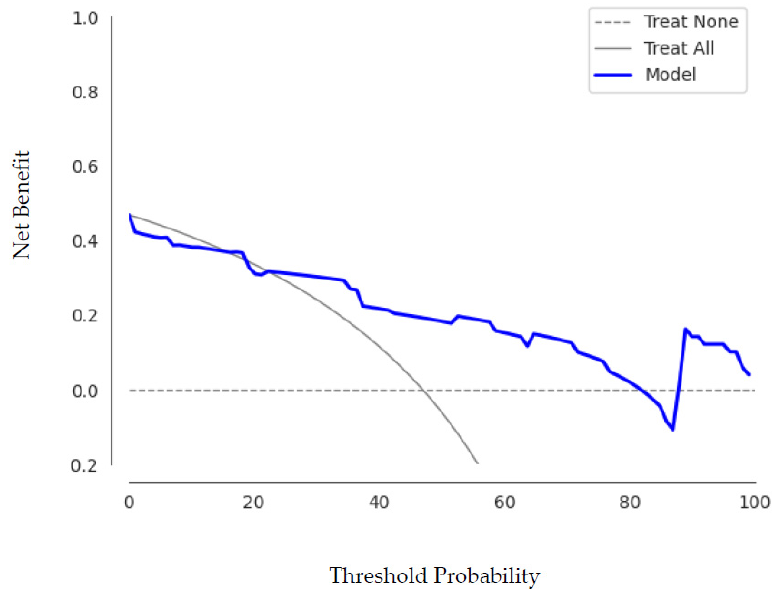
Figure 6. The decision curve analysis for the best run of PCA KNN shows that within a threshold probability from 25% to 55%, checking patients based on the classification model leads to a higher benefit than checking no or checking all lymphomas more frequently. Table 3. The outcome of the deep learning models.